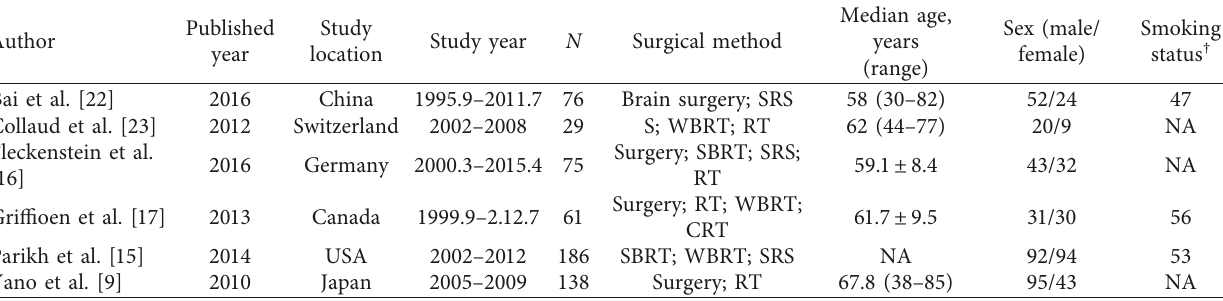
Table 1: Characteristics of included studies.